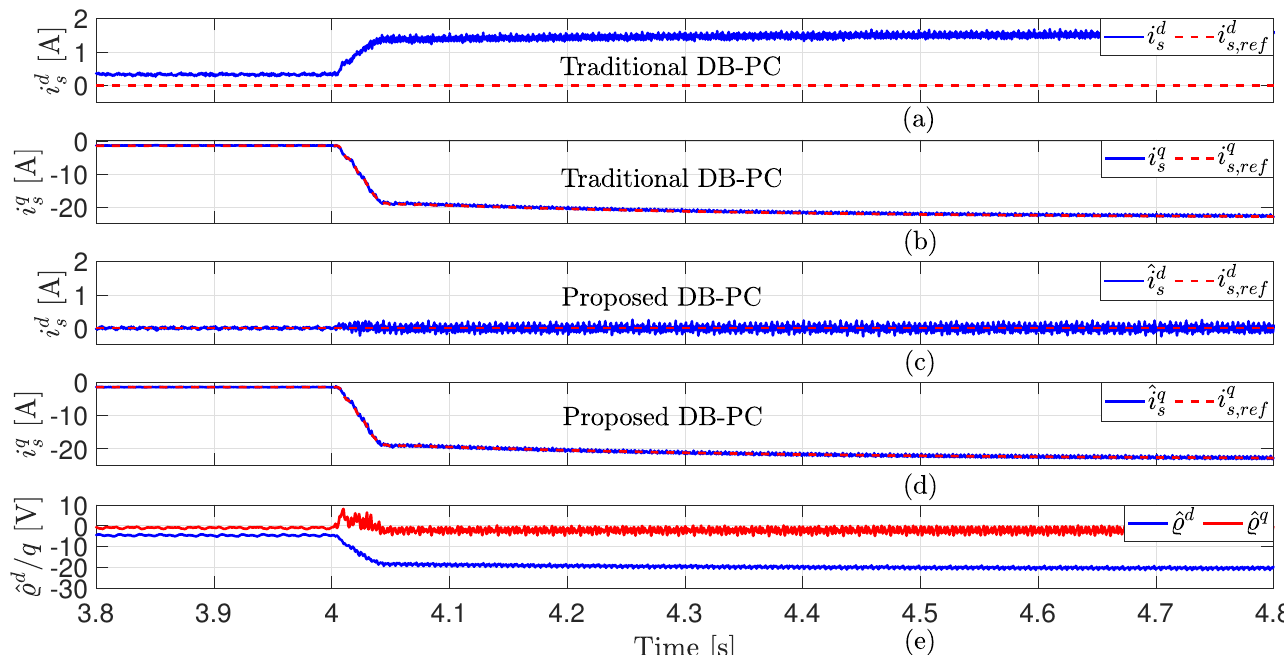
Figure 13. Experimental results of the proposed DB-PC and traditional one with change of the torque and speed at the same time: ( a ) actual and reference d -axis currents, ( b ) actual and reference q -axis currents, ( c ) observed and reference d -axis currents, ( d ) observed and reference q -axis currents, and ( e ) observed total disturbance for d and q